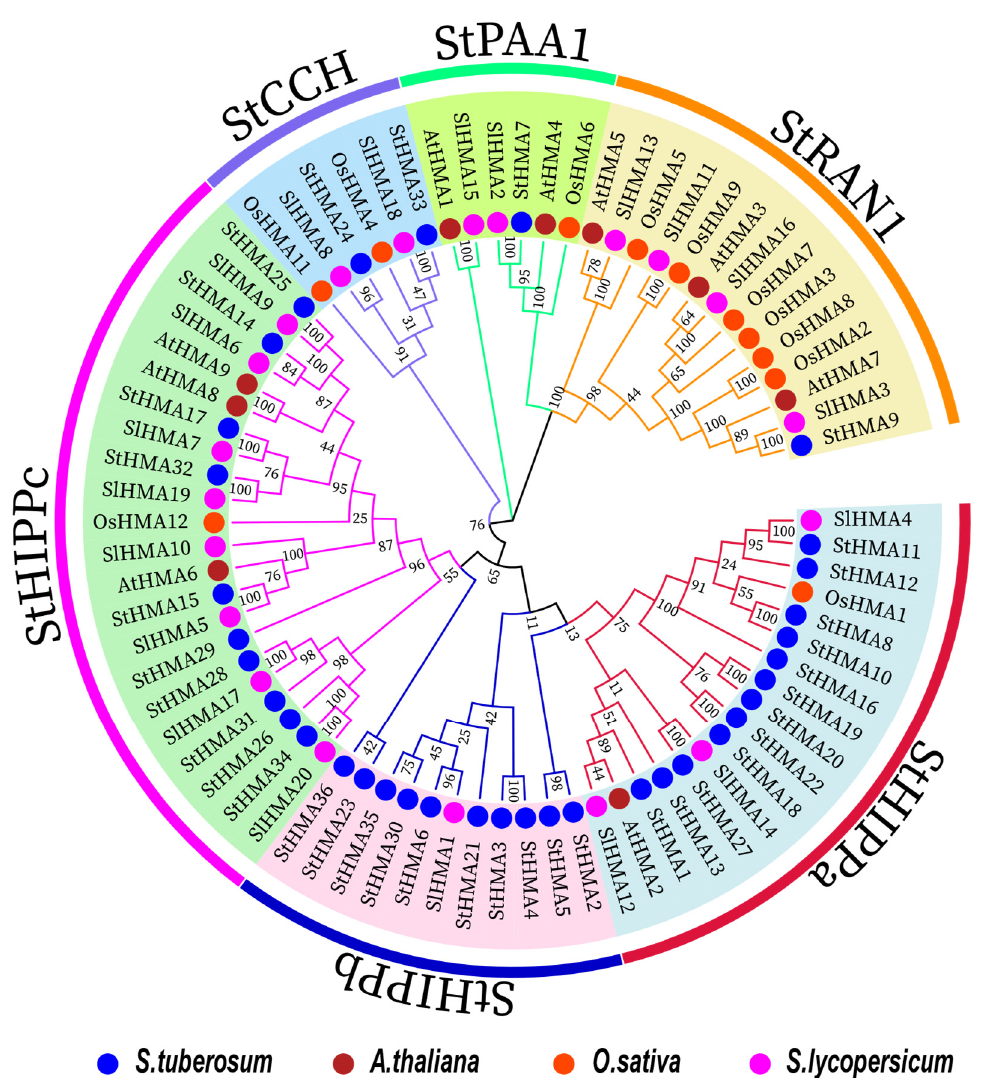
Figure 4. Phylogenetic relationships among 78 heavy-metal-associated proteins in Solanum tuberosum , Arabidopsis thaliana , Oryza sativa and Solanum lycopersicum . The maximum likelihood tree was created using MEGA X (bootstrap value = 1000) and the bootstrap value of each branch is displayed. The blue solid circles, brown solid circles, red solid circles and pink solid circles represent heavy-metal-associated proteins from potato, Arabidopsis , rice and tomato, respectively.